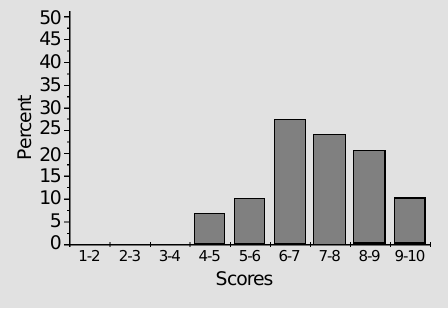
from 1 to 10 (Source: Under-